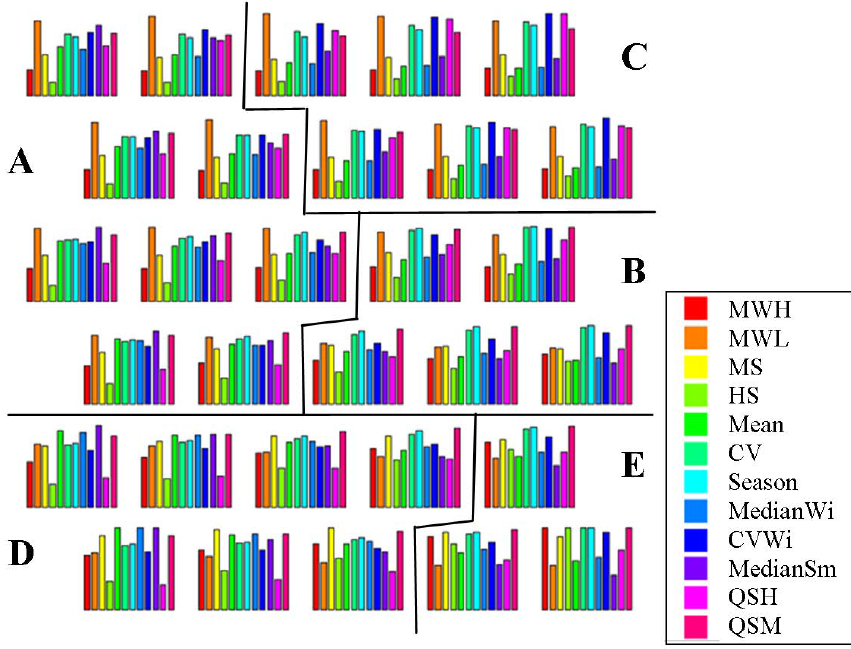
Fig. 7. Distribution of index properties for each neuron as bar charts. Lines indicate cluster border, letters cluster names.